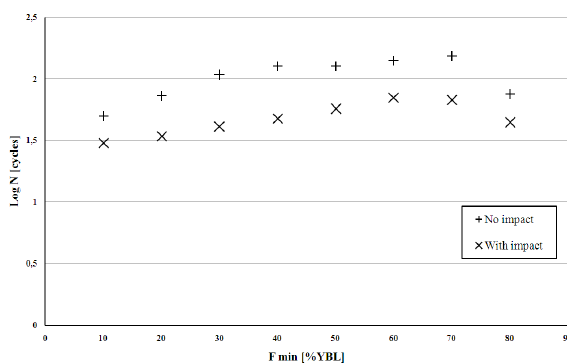
Figure 3. Cycles up to failure versus load ranges: superposed